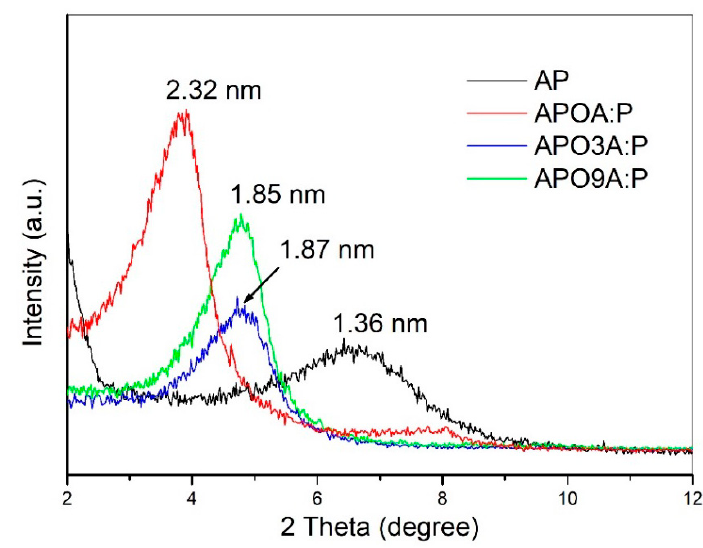
Figure 1. X-ray diffraction (XRD) patterns of the purified clay (AP) and organically modified purified clay with a mixture of surfactants A-P containing different amounts of alkyl ammonium (A) and alkyl phosponium (P).